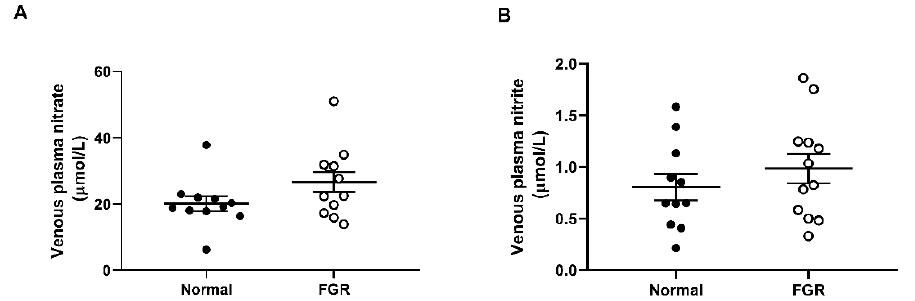
Figure 3. Fetal plasma concentrations of nitrate and nitrate are not different between normal and FGR pregnancies. Nitrate ( A ) and nitrite ( B ) concentrations (µmol/L) measured in umbilical vein plasma from both normal and FGR pregnancies. n = 11 – 12 per group.